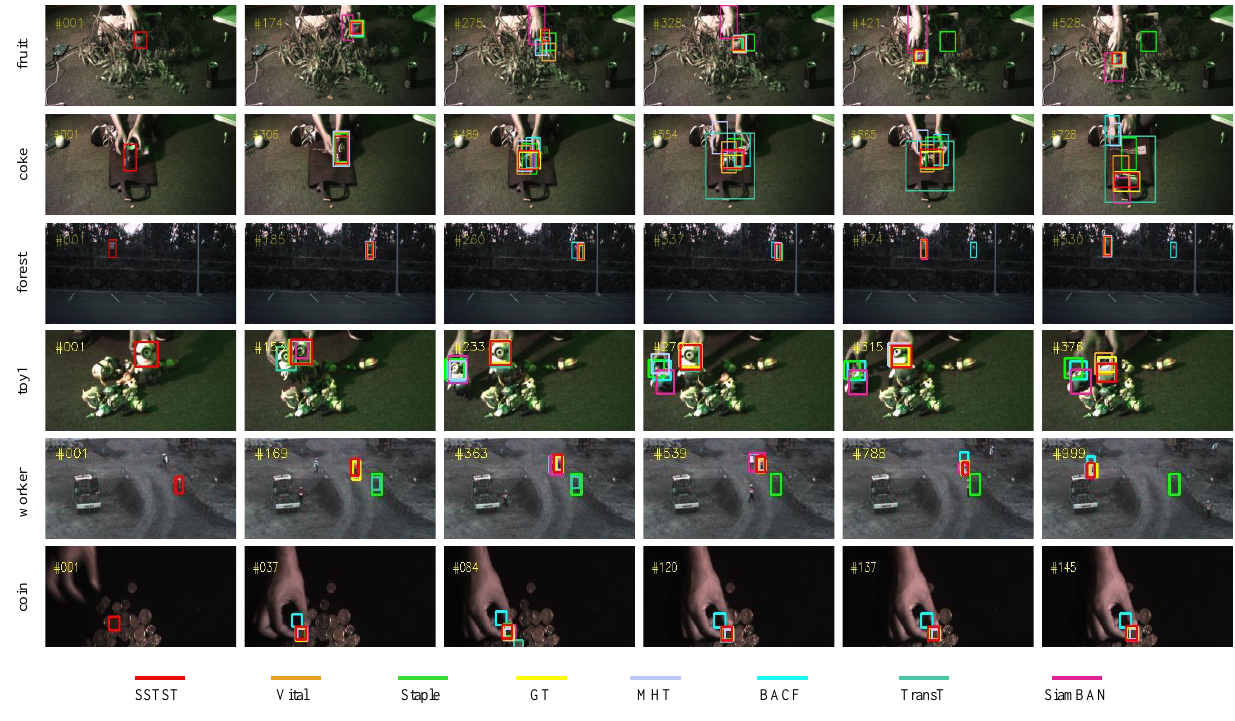
Figure 9. Qualitative results of the proposed method on some challenging sequences on